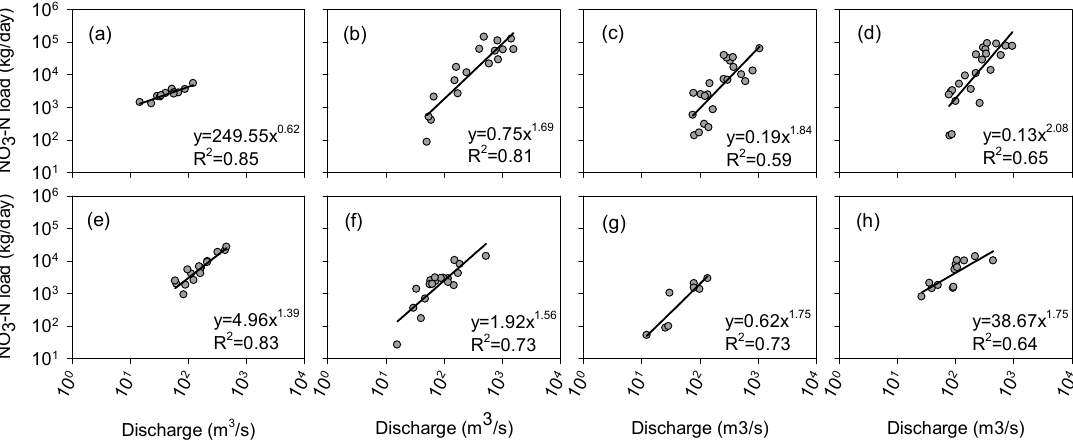
Figure 6. Relationships between the observed discharge and NO3-N load at the Grand Forks gauging station for different months from 2003 to 2017: ( a ) November, December, January, February, and March; ( b ) April; ( c ) May; ( d ) June; ( e ) July; ( f ) August; ( g ) September; and ( h ) October (R 2 denotes the Pearson product-moment correlation coefficient).